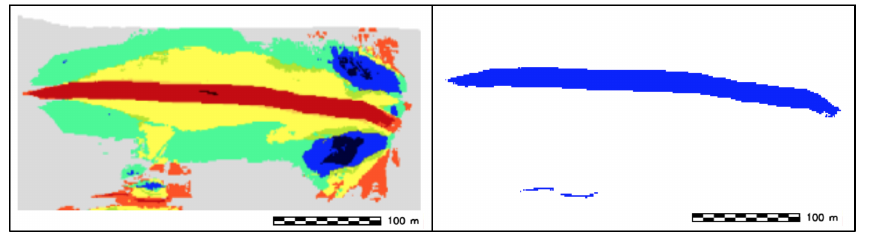
Figure 7. Extraction of sand wave crest (SWC).